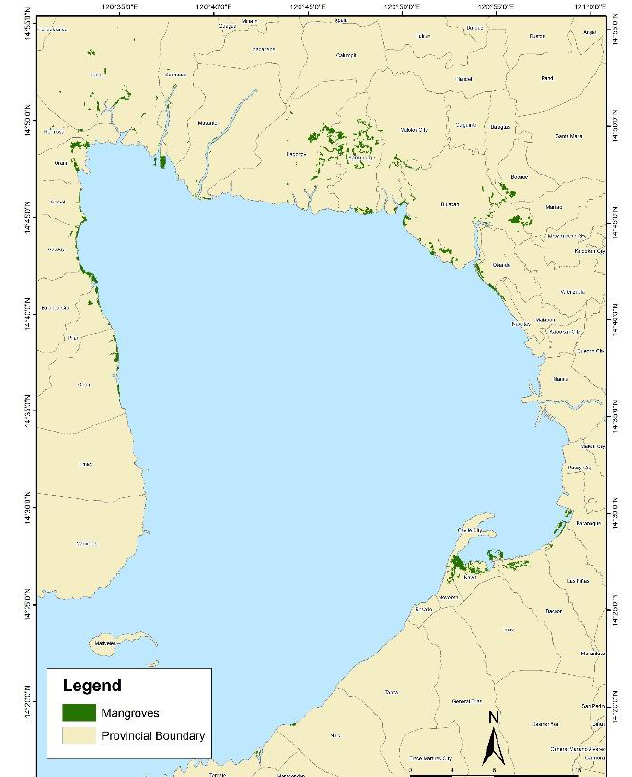
Figure 10 . Sample map output